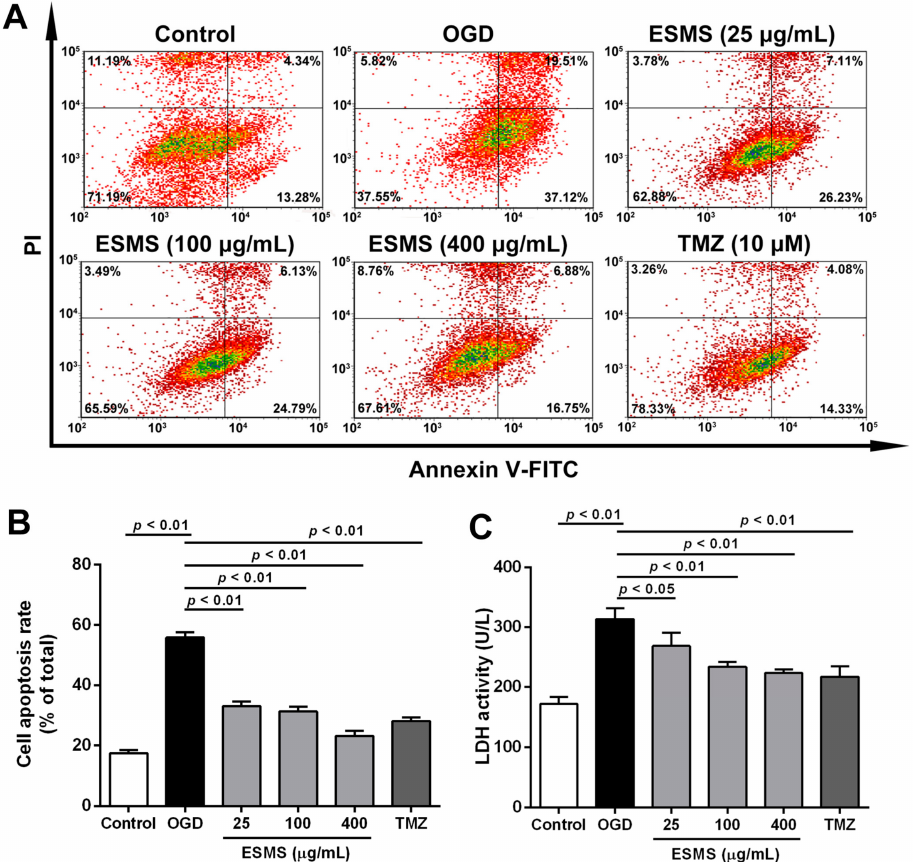
Figure 4. ESMS decreased apoptosis in H9c2 cells subjected to oxygen glucose deprivation (OGD). ( A ) Flow cytometric analysis of Annexin V-FITC/PI-stained H9c2 cells. Viable cells are